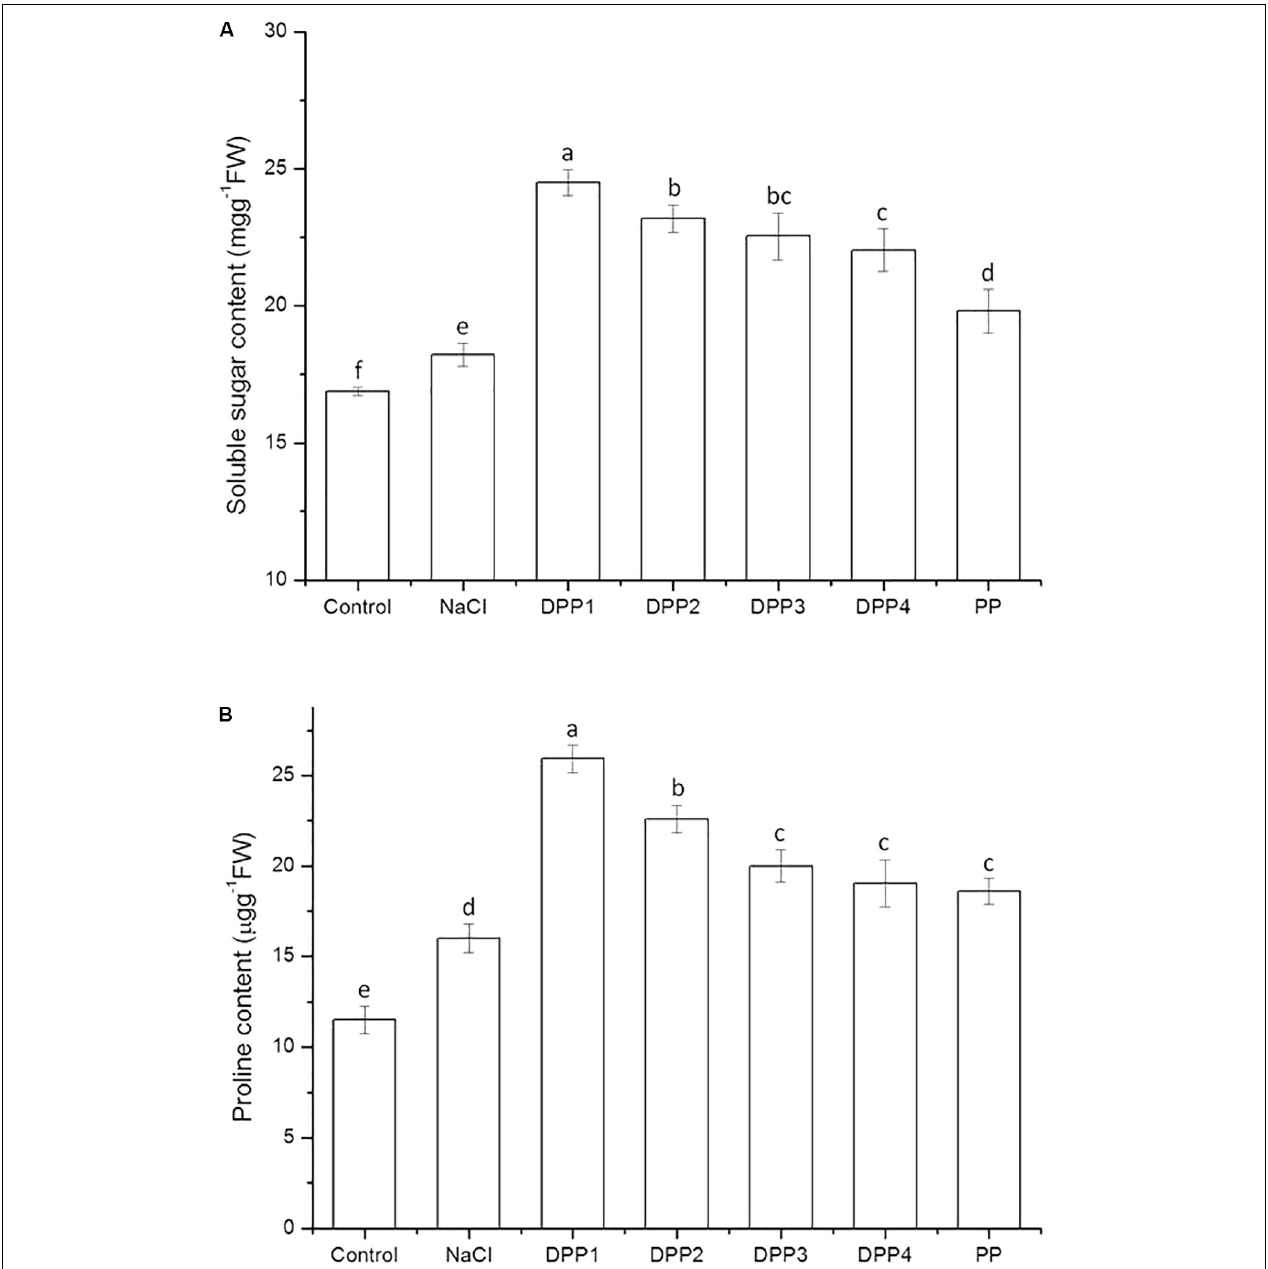
FIGURE 4 | Effect of four degraded (DPP1,2,3,4) and natural polysaccharides (PP) from P. yezoensis on soluble sugar (A) and proline content (B) in wheat seedlings. Values are the mean ± SD of three replicates. Different letters indicate significant differences at P <